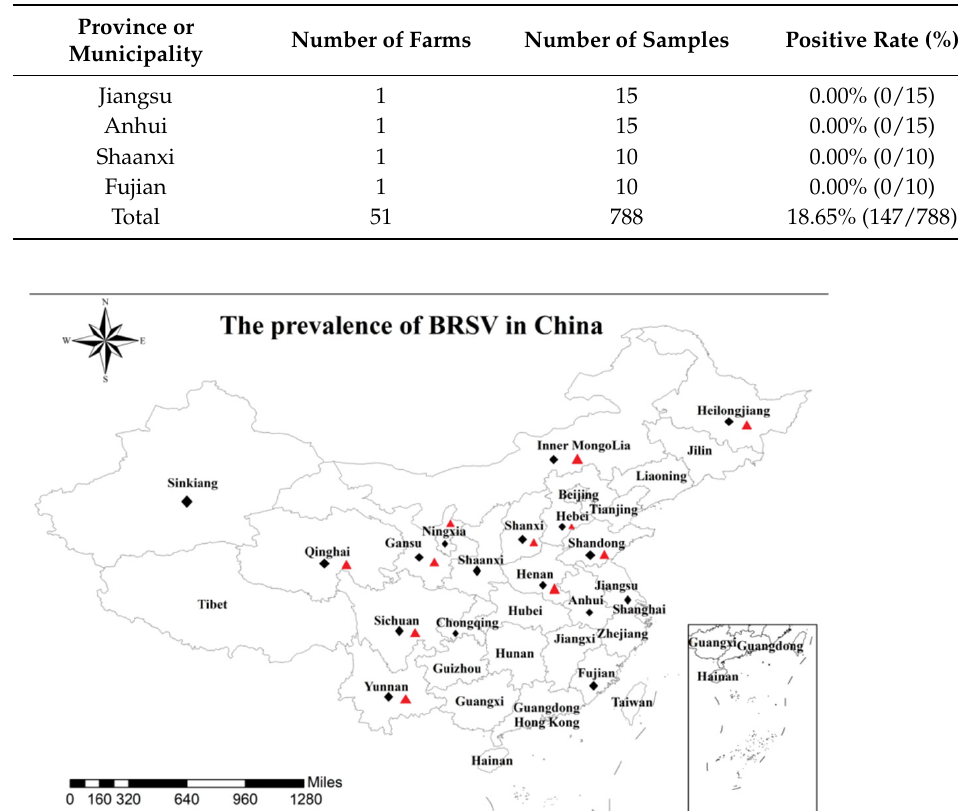
Figure 1. Map of China shows the geographical distribution of BRSV strains by province or munic ‐ ipality, Indicates the province or municipality of the sample collected in this study, Indicates provinces with BRSV positive ‐ sample distribution.